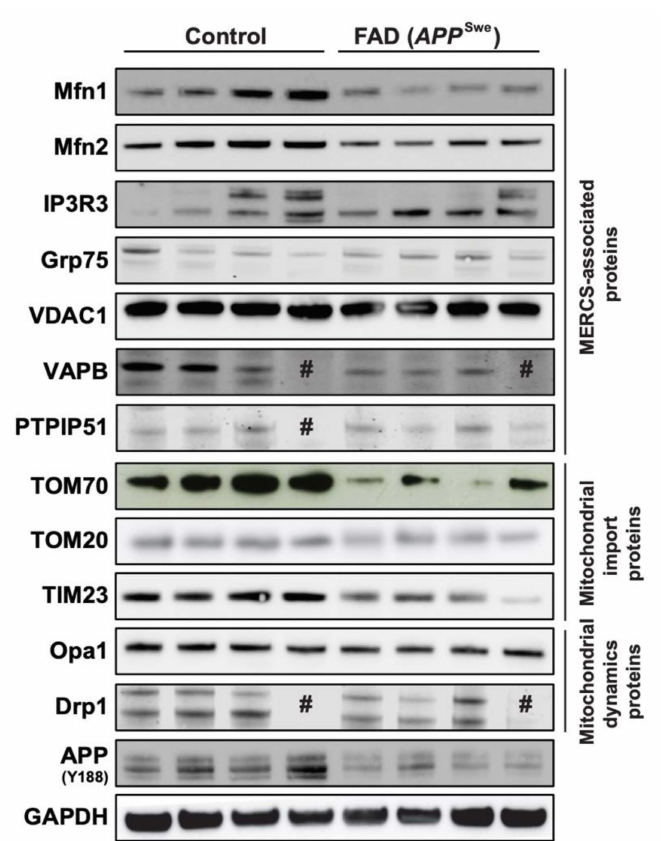
Figure 1. Mitochondria-endoplasmic reticulum (ER) contact sites (MERCS)-associated proteins Mitofusin1(Mfn1), Mitofusin2(Mfn2)andtranslocaseoftheoutermitochondrialmembrane70(TOM70) are altered in familial Alzheimer’s disease (FAD) post-mortem brain. Post-mortem frontal cortices were homogenized, sodium dodecyl sulphate–polyacrylamide gel electrophoresis was performed, and proteins were stained as indicated. Representative immunoblots of MERCS-associated proteins, mitochondrial import proteins and mitochondrial dynamics proteins. # sample loaded but no band observed ( n =